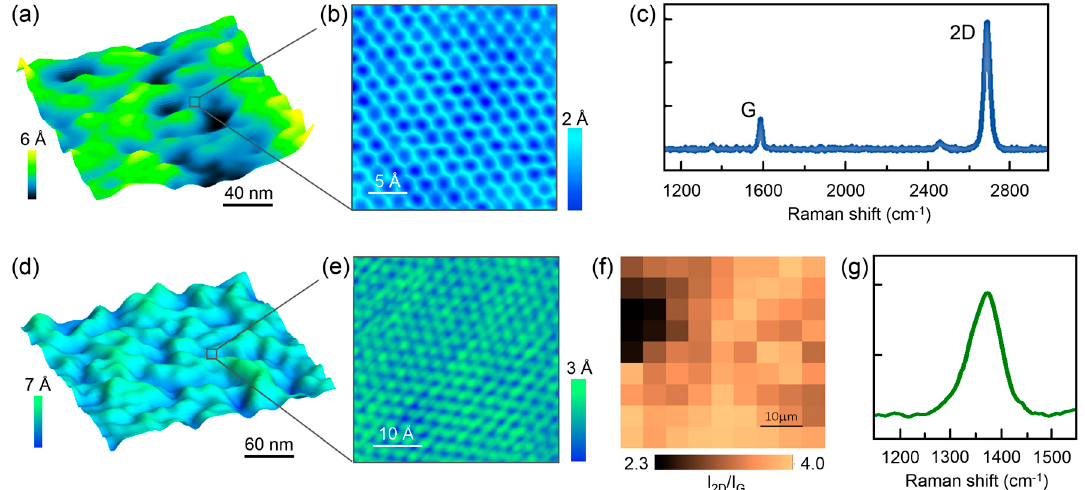
Figure 3. Characterization of h-BN and graphene coatings. ( a ) Atomic force microscopy image of SLG transferred onto glass; ( b ) Scanning tunneling microscopy atomic-resolved image of SLG; ( c ) representative Raman spectrum of SLG; ( d ) STM image of h-BN; ( e ) STM atomic-resolved image of h-BN; ( f ) Raman map of SLG; and ( g ) representative Raman spectrum of h-BN .